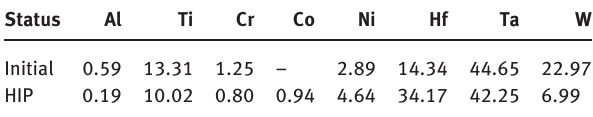
Table 3: Chemical composition of carbides for K002